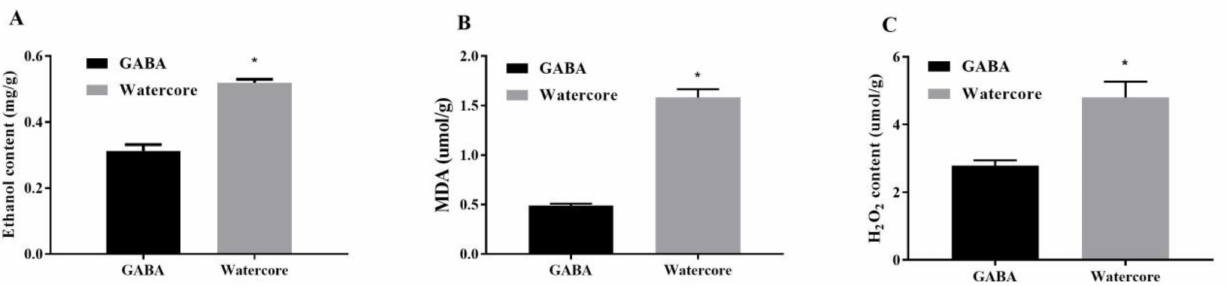
Figure 1. Analysis the content of ethanol ( A ), MDA ( B ) and H 2 O 2 ( C ) in the watercore and GABA treatment of ‘Akibae’ fruits. The asterisk on the bars represent standard errors from three independent replicates. * p < 0.05.